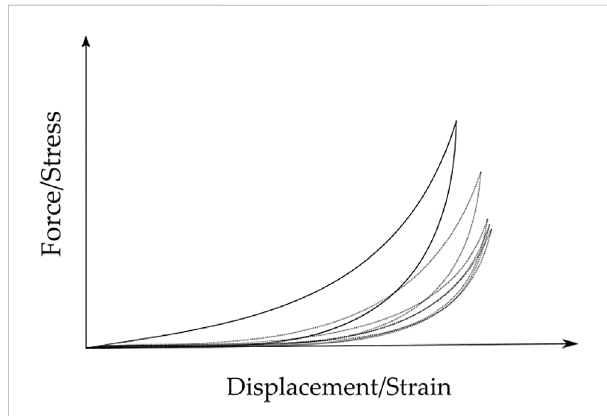
FIGURE 3 Typical Force/Stress vs. Displacement/Strain loading-unloading curves for breasttissue samples, over fi vecycles.Hysteresis decreases with the increase of cycles. Full line - fi rst cycle; dotted lines - second to fi fth